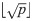
Error rate estimates for the real data study.Shown are different error rate estimates for six real data sets with two or three response classes, respectively, of nearly the same size. The error rate was estimated through the test error, the OOB error, the stratified OOB error, the CV error, and the stratified CV error for settings with different sample sizes, n, and numbers of predictors, p. The mean error rate over 1000 repetitions was obtained for a range of mtry values. The vertical grey dashed line in each plot indicates the most commonly used default choice for mtry in classification tasks, that is ⌊p⌋.